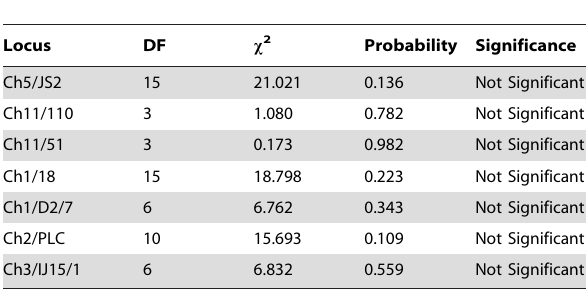
Table 5. Hardy-Weinberg analysis for the combined population of group 2 T. b. gambiense and T. b. brucei at the Coˆte d’Ivoire focus (N=25).